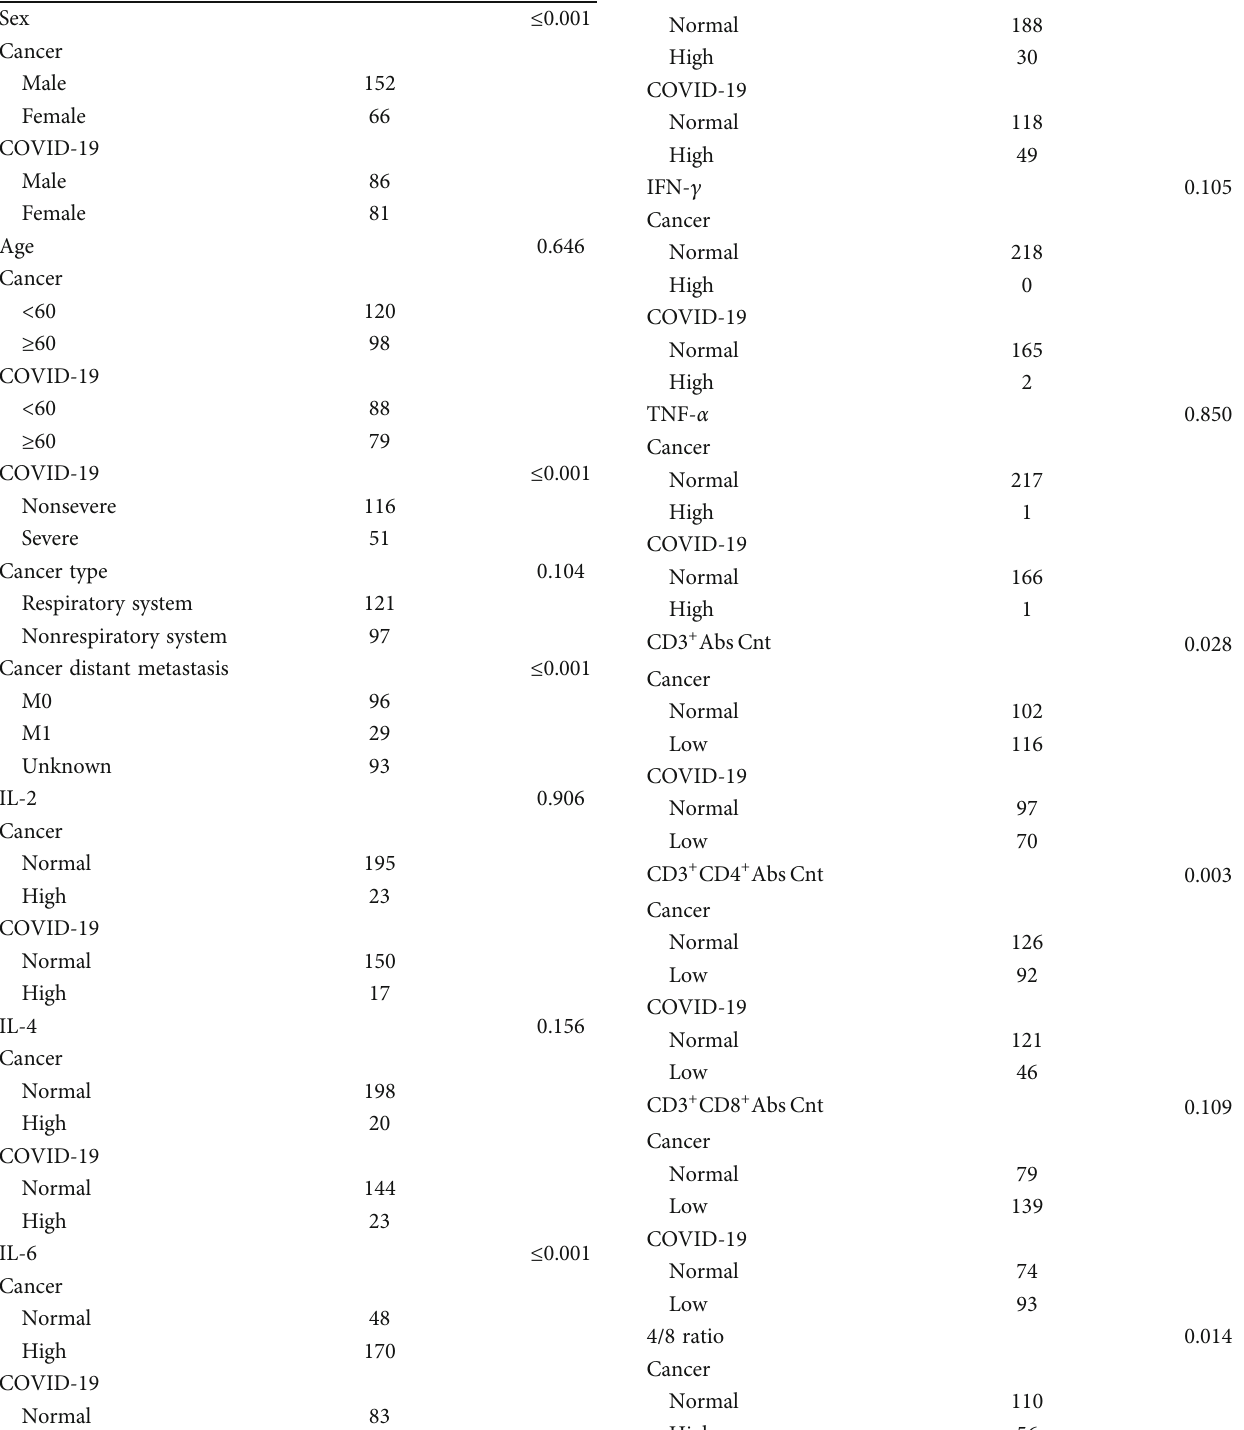
Table 1: Baseline parameters between COVID-19 and cancer patients.